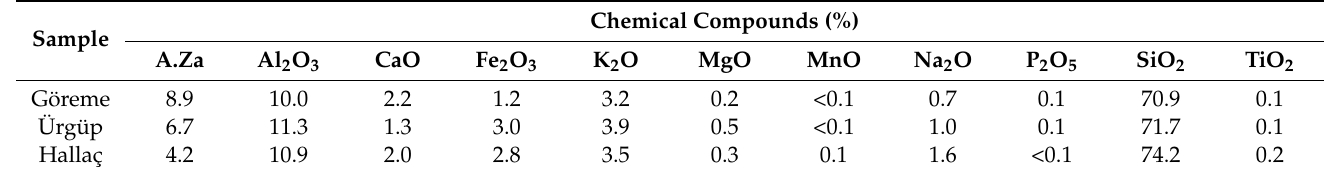
Table 2. Results of the Quantitative Mineral Test on the tuff stone samples from Göreme, Ürgüp, and